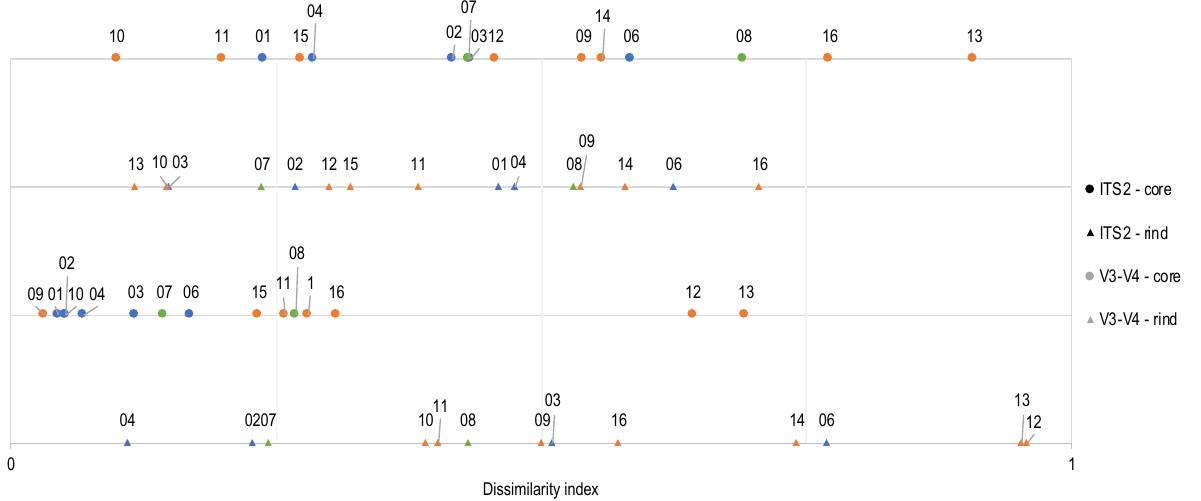
Figure 4. Similarity of cheese microbiota from different years according to the Bray–Curtis dis- similarity index. The Bray–Curtis index shows the similarity (0–0.75) or dissimilarity (0.76–1) of the cheeses from different productions (2015 and 2018). The index has been calculated for fungi (ITS2) and bacteria (V3–V4) from cheese rind ( ▲ ) and cheese core ( ○ ). Numbers shown are cheese identi- fication numbers for the bloomy- (blue), natural- (green) and washed-rind cheeses (orange).